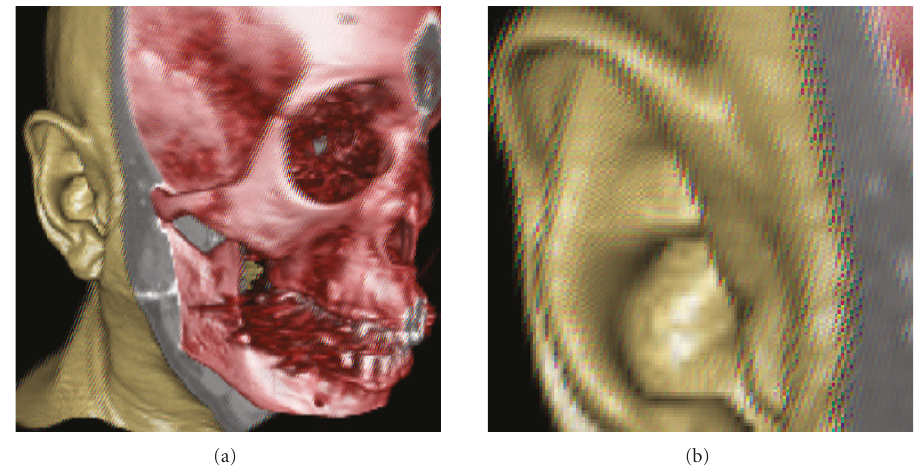
Figure 11: (a) The raw output signal that is sent to the lenticular display. Please note that the Moir´e-like structures are not artifacts, but can be contributed to the interweaved subpixels, belonging to di ff erent views. (b) A zoomed fragment of the left